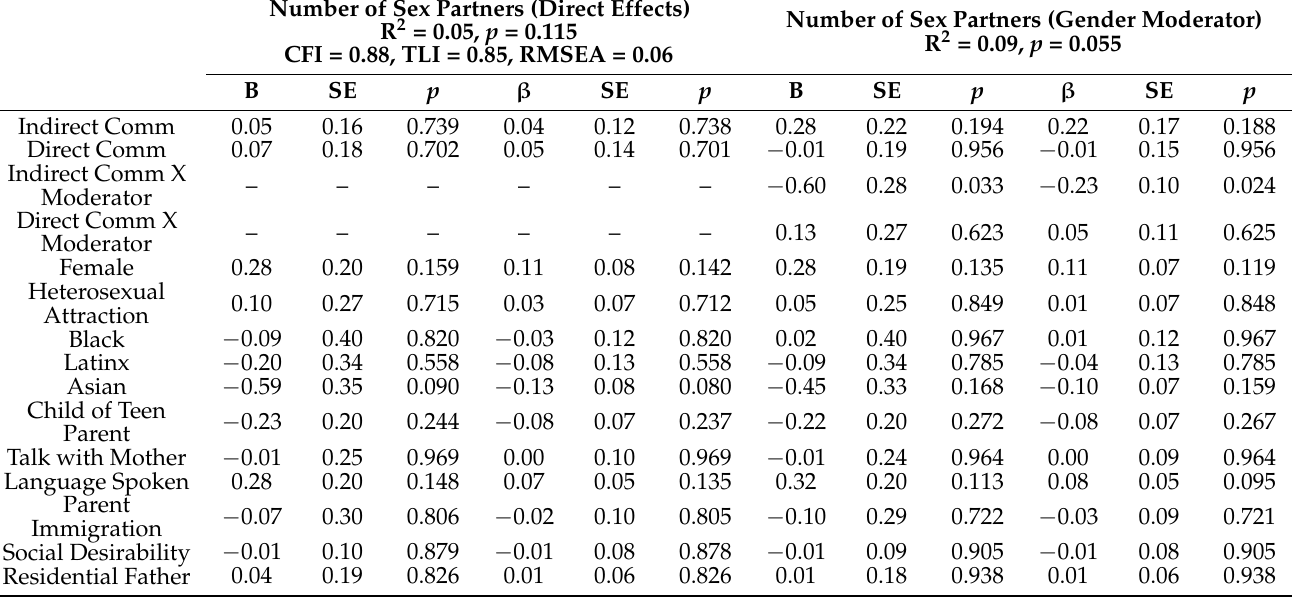
Table 4. Moderating effects on communication about sex and number of